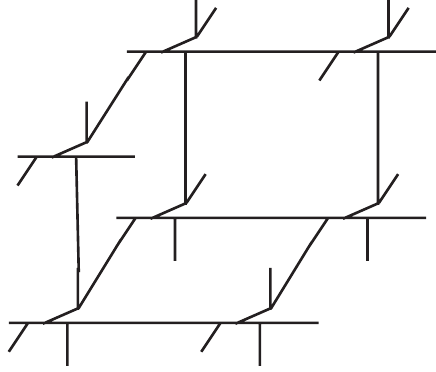
FIG. 4. Trivalent resolution of the cubic lattice [30].